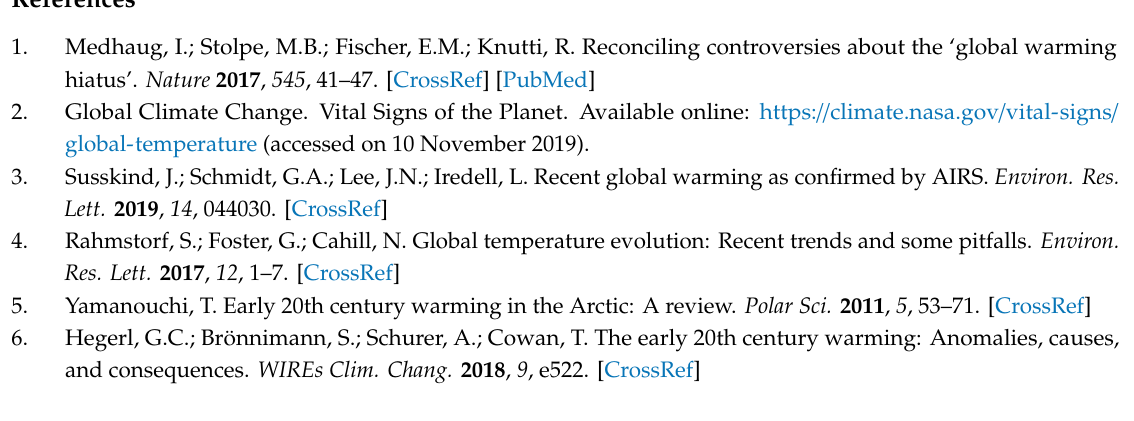
Figure A2. Pearson correlation coefficients among all weather stations in March (1951–2016 period).